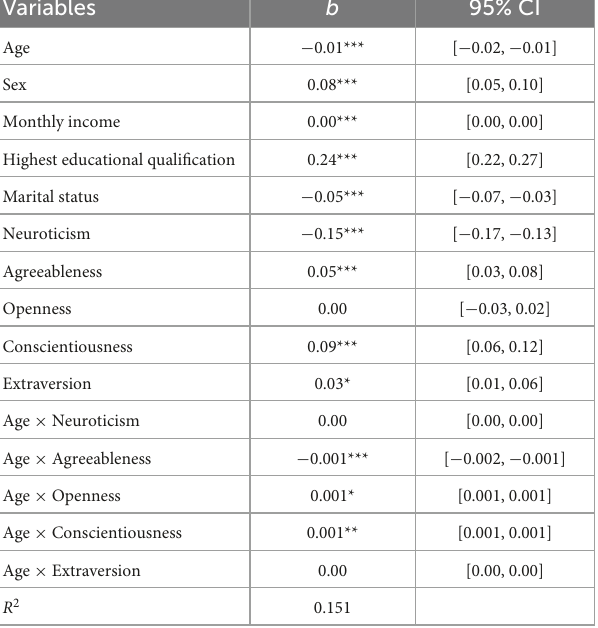
TABLE 2 The regression coefficient ( b ) for demographics, personality traits, and age (continuous) by personality traits interactions with the total explained variances ( R 2 ).